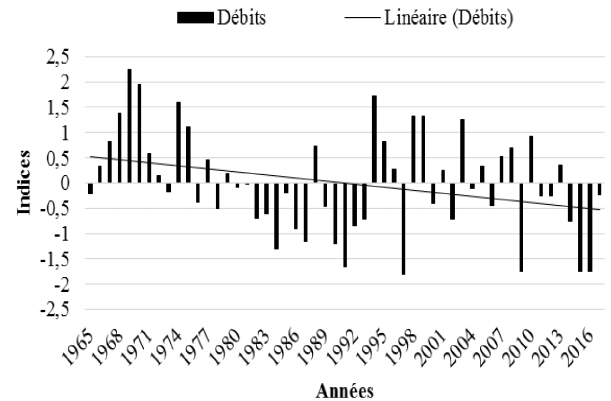
Figure 3. Variabilité interannuelle des débits dans le bassin Béni- nois de la Pendjari à Porga.